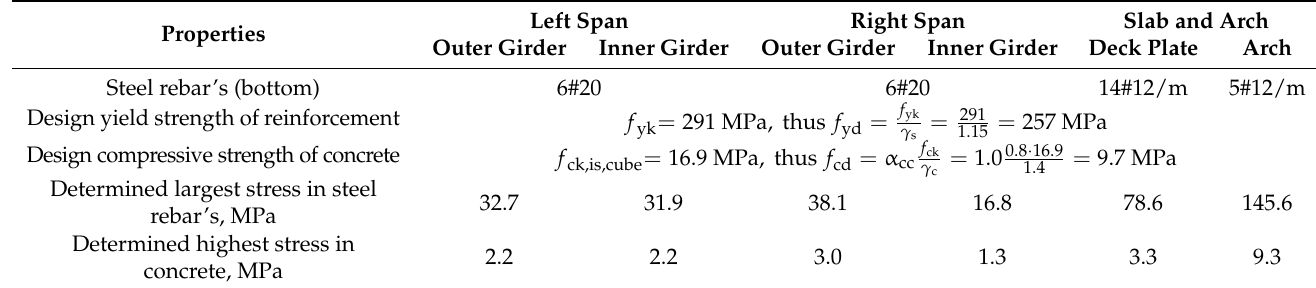
Table 5. Materials characteristic and calculated extreme stresses in concrete and steel